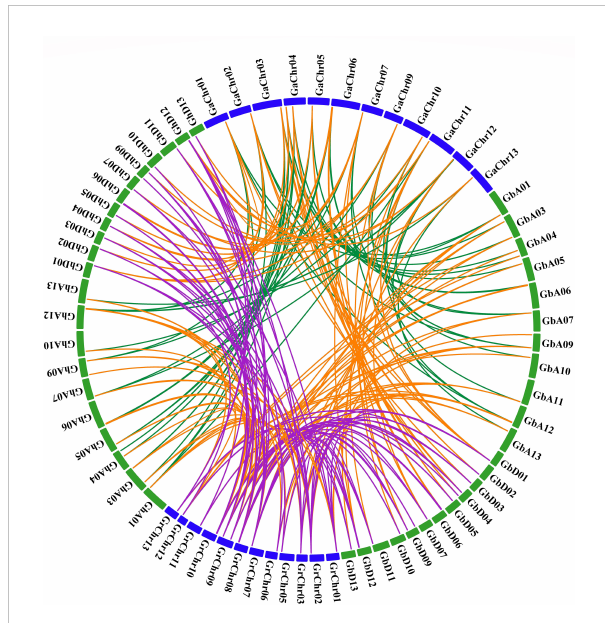
FIGURE 2 The synteny and duplication of HVA22s among four cotton